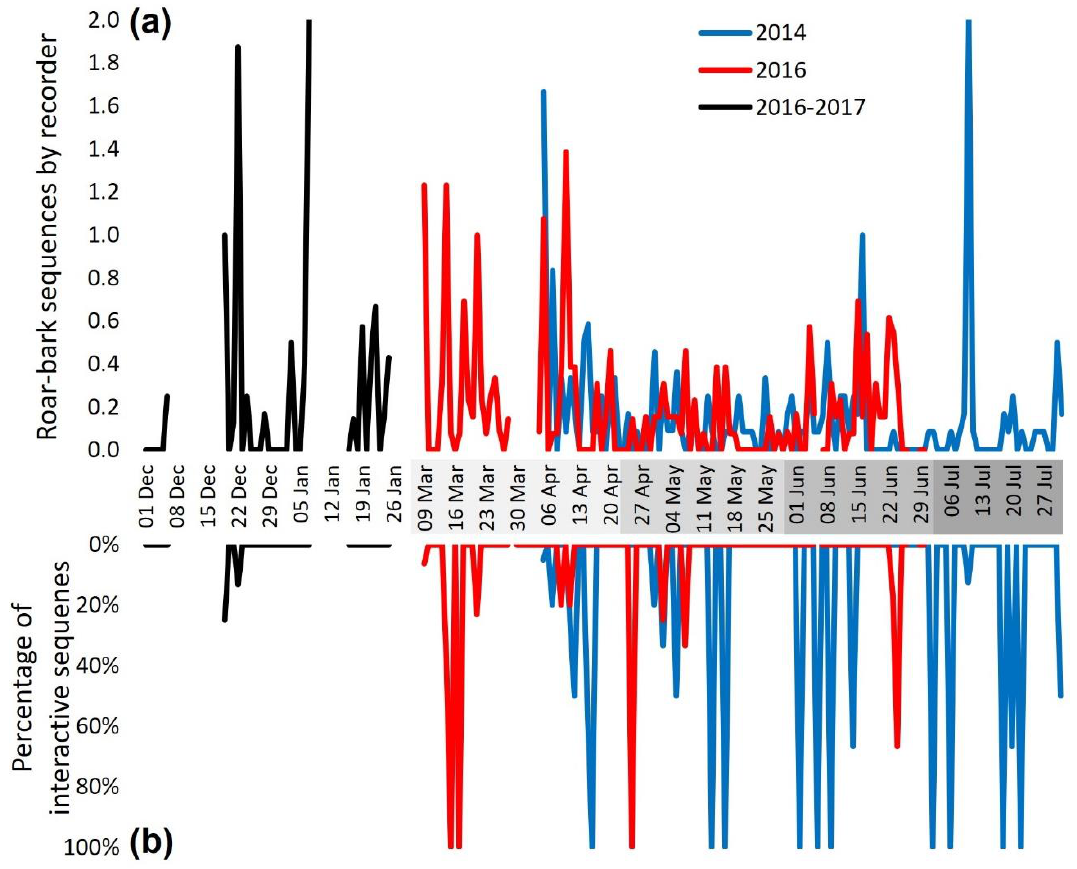
Figure 5. ( a ) Seasonal distribution of maned wolf roar-bark sequences recorded at the Serra da Canastra National Park, Brazil. Each point is a night (the first 3 h). Periods are separated by the grayscale in the dates (non-reproductive, mating, gestation, parturition, and initial parental care, consecutively). The number of sequences found was divided by the number of active recorders at that moment (4–13 Wildlife Acoustic SongMeters 2). ( b ) Percentage of sequences in which 2 maned wolves were participating.